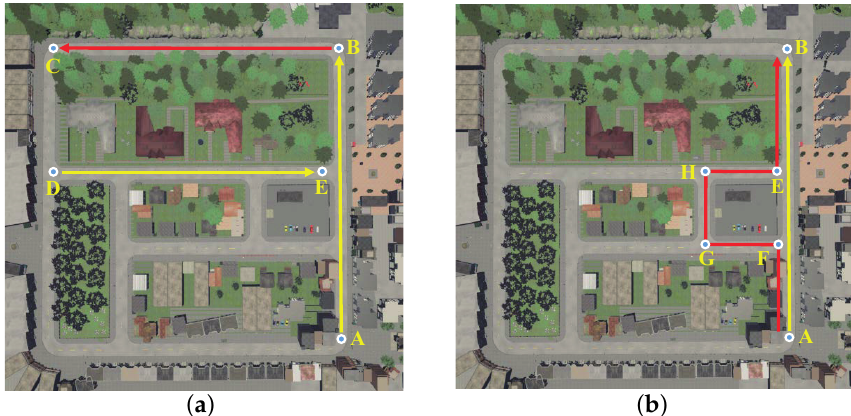
Figure 9. The virtual experiment environment. In subfigure ( a ), A → B section and D → E section were used for the training and testing of the DNN reward model, and B → C section was used to verify the effect of the trained DNN reward model. In subfigure ( b ), A → B section and A → F → G → H → E → B section were used to train and test the DDPG model.